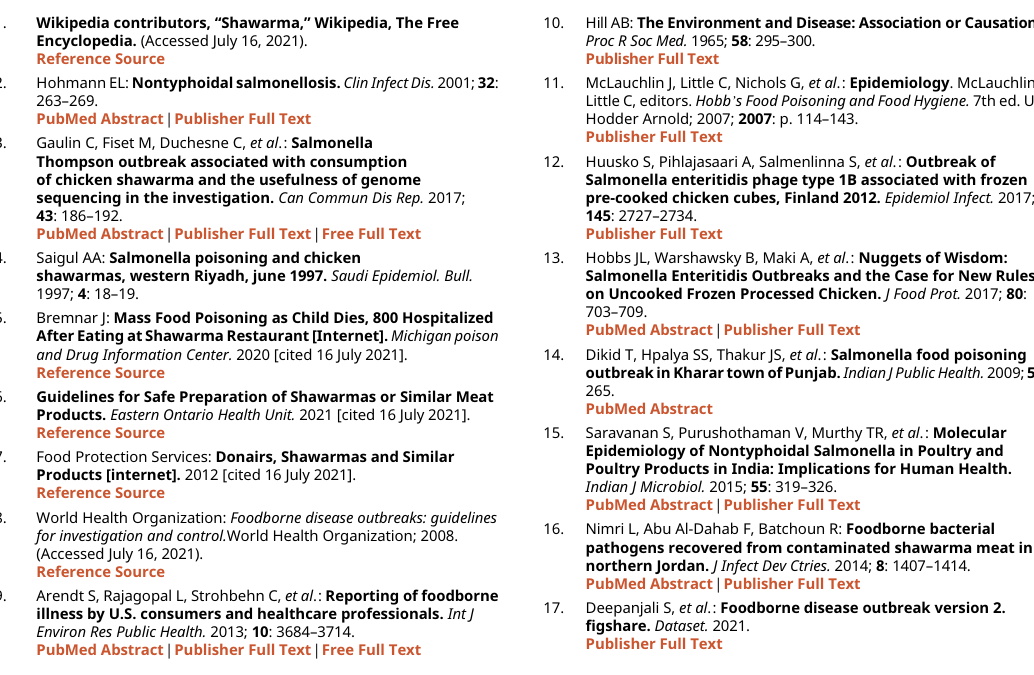
Figshare: Foodborne disease outbreak version 2. https://doi.org/10.6084/m9.figshare.15022065.v2. 17